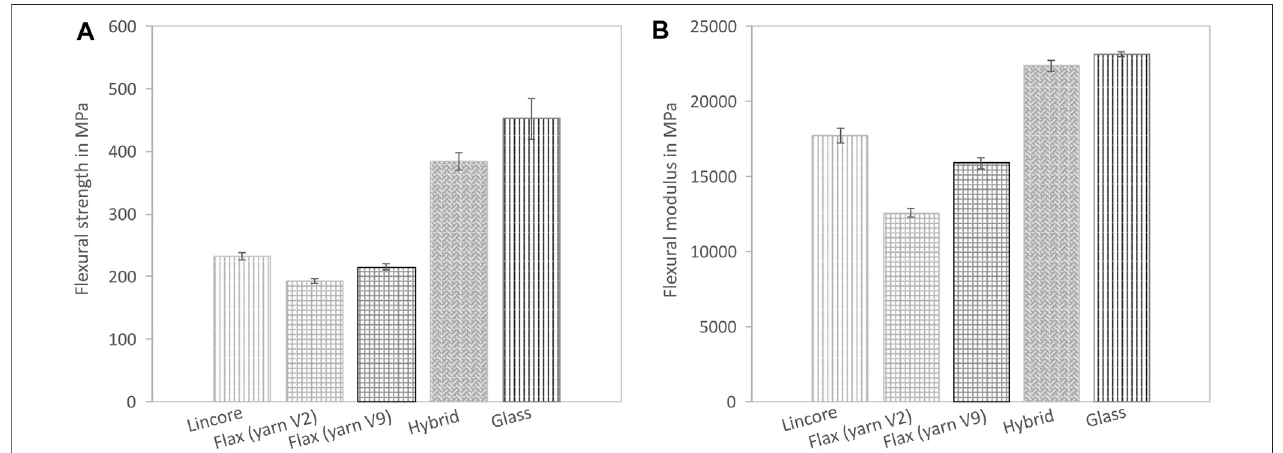
FIGURE 5 | Flexural strength (A) and fl exural modulus (B) of composite laminates (mean value ± standard deviation).